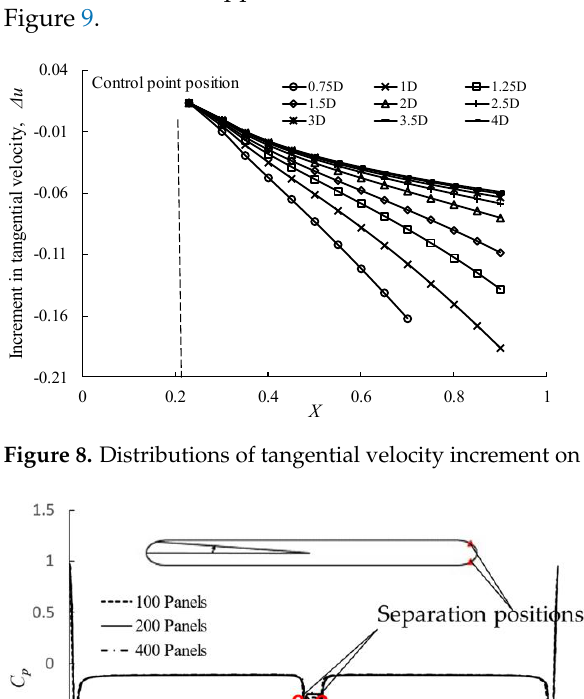
Figure 10. Results from the iterative wake length procedure of the train. The pressure coefficient is distributed almost symmetrically on the upper surface and the lower surface of the 2-D train. When the flow encounters the train, the stagnation point appears where the pressure coefficient is the maximum. As the flow passes the train head, the pressure decreases rapidly to the minimum, and then increases until the flow reaches the body of the train. The pressure along the train body remains constant and then drops